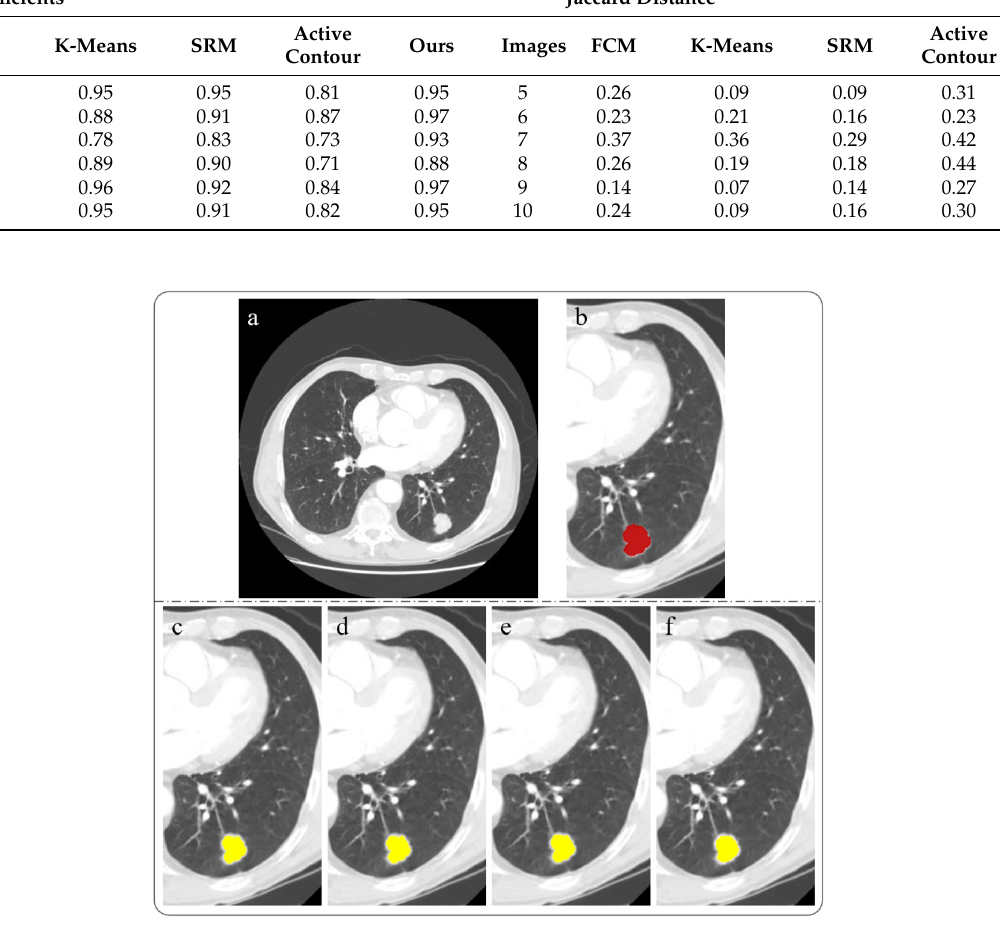
Figure 5. Segmentation results obtained by different methods, the red area is the segmentation result of our method, and the yellow area is the segmentation result of the other four methods, ( a ) input image, ( b ) our method segmentation result, ( c ) FCM segmentation result, ( d ) K-means segmentation result, ( e ) SRM segmentation result, ( f ) active contour segmentation result. Table 2 shows the dice coefficient and Jaccard distance of our proposed method and other methods in 10 groups of experiments. distance obtained by different methods.